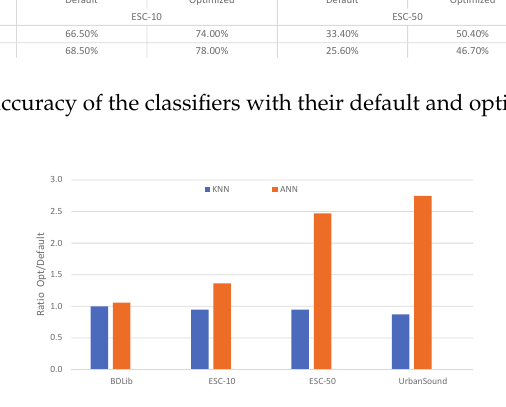
Figure 7. Relative improvement of optimised parameters over default parameters of the